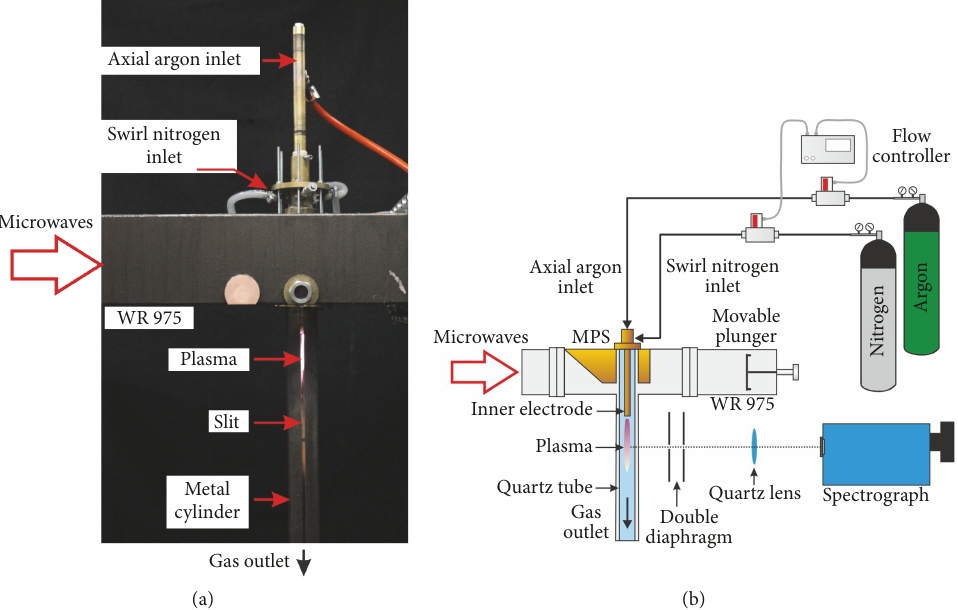
Figure 1: (a) Photo of the microwave plasma source and (b) the experimental setup used for the spectroscopic